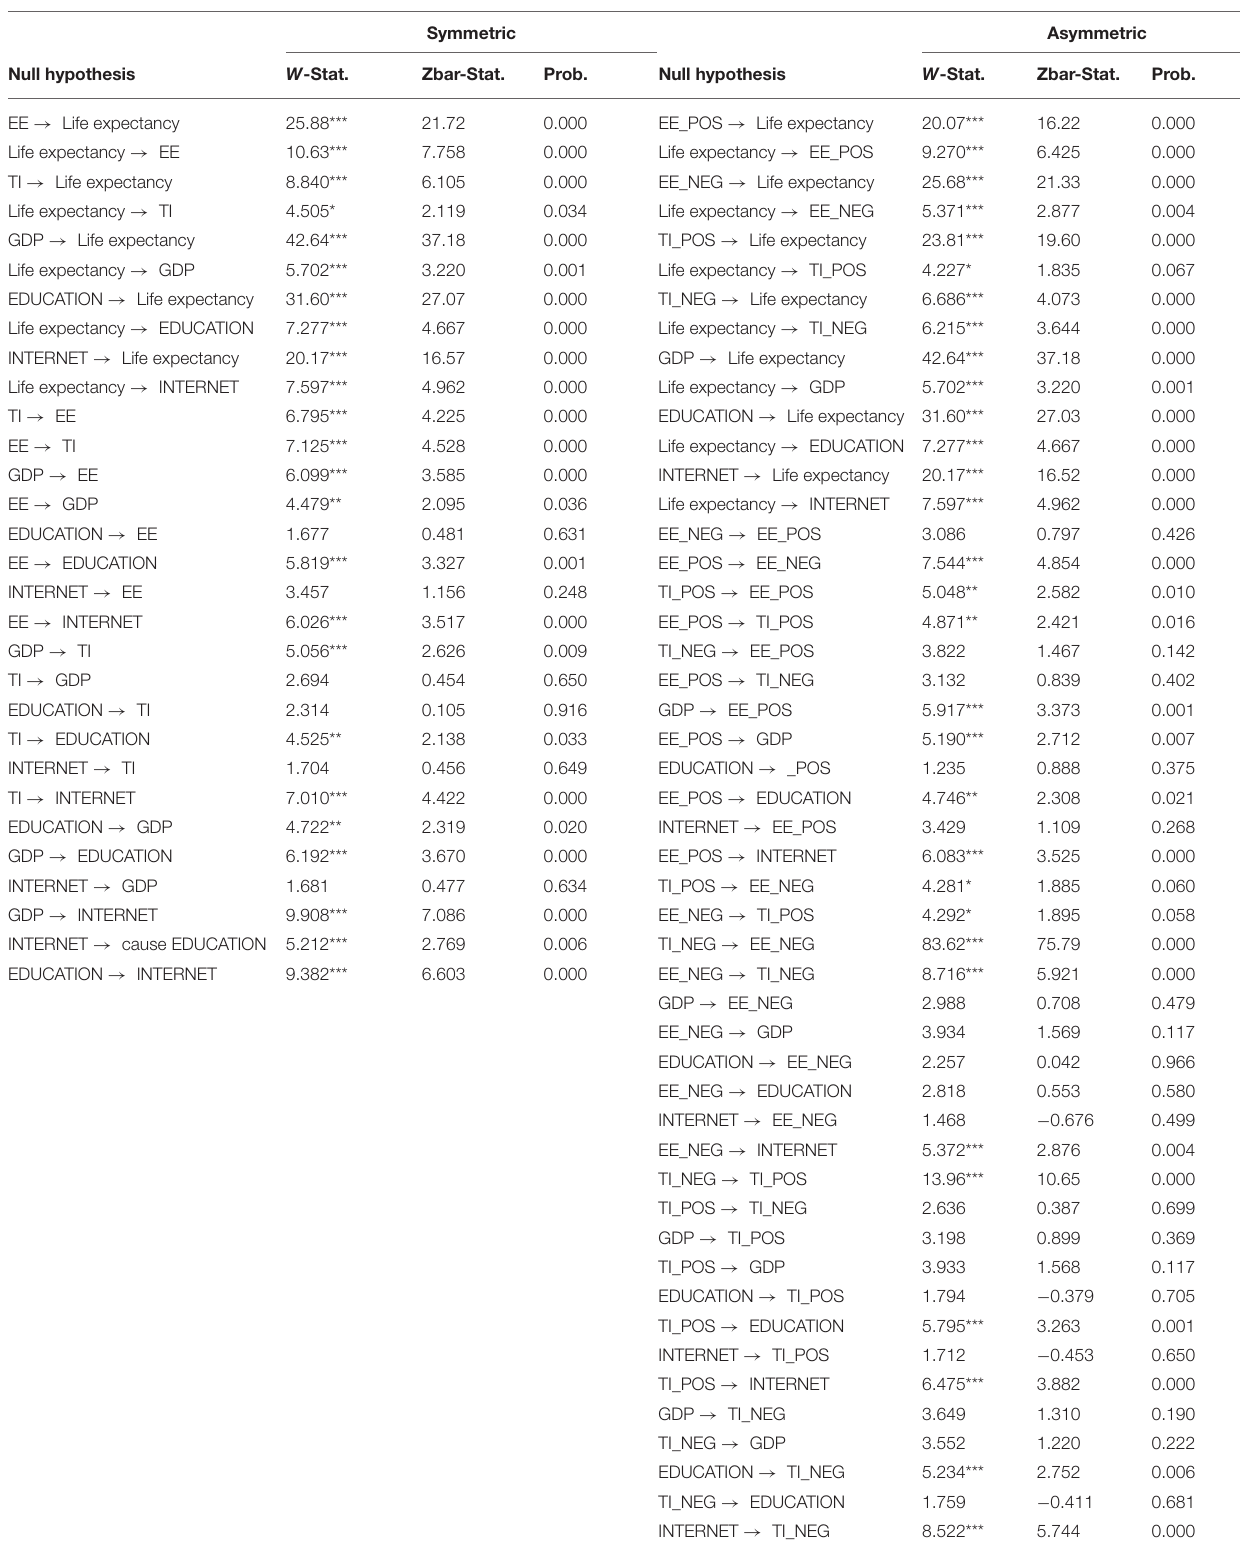
TABLE 4 | Symmetric and asymmetric Granger